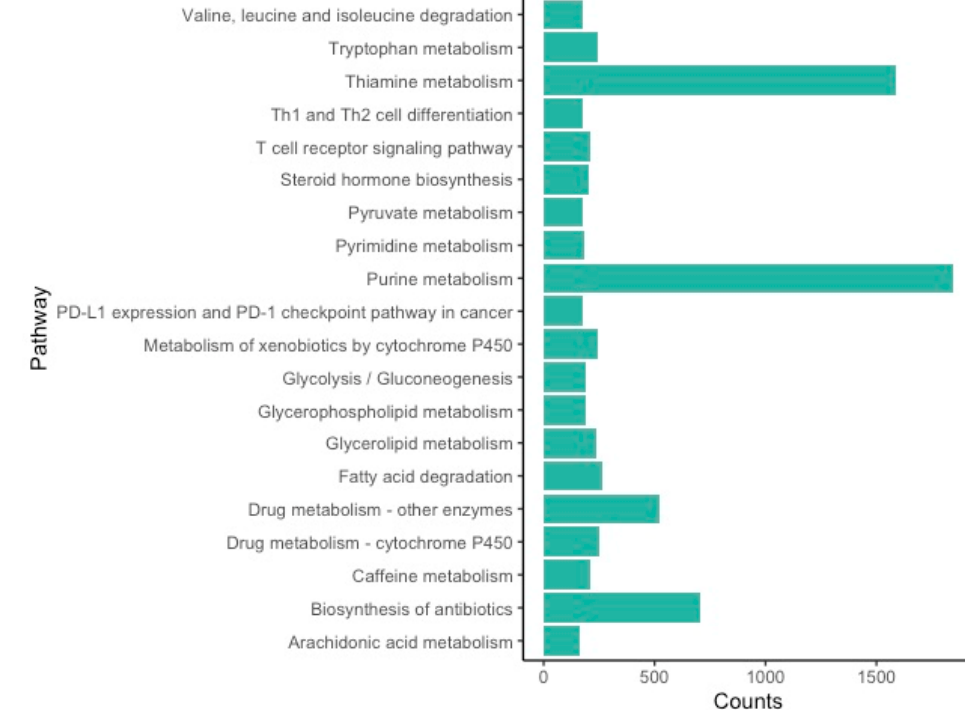
Figure 2. Kyoto Encyclopedia of Genes and Genomes (KEGG) Top 20 pathways for the L. hesperus ovarian transcriptome.